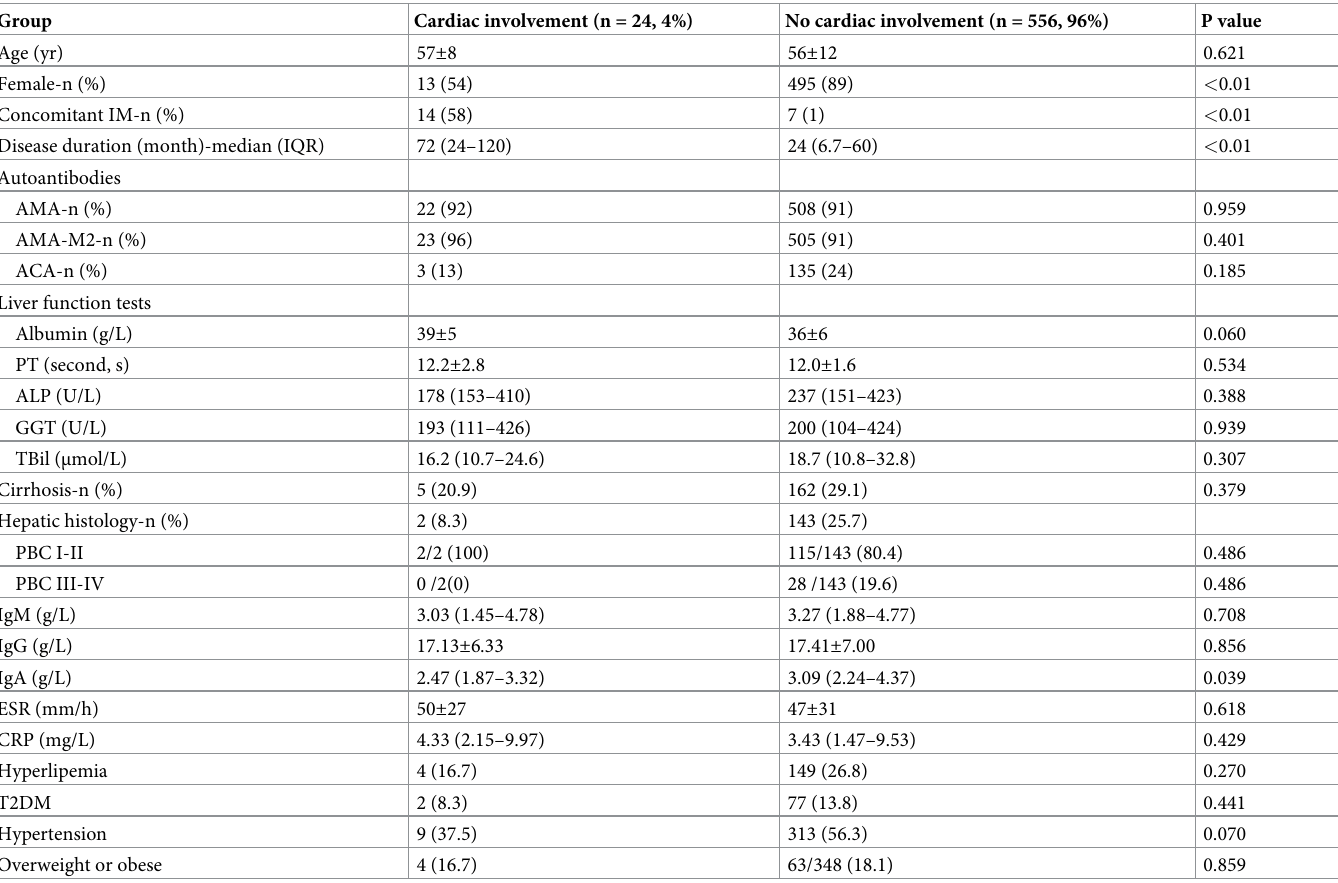
Table 1. Demographics, clinical manifestations, and laboratory examinations of PBC patients with or without cardiac